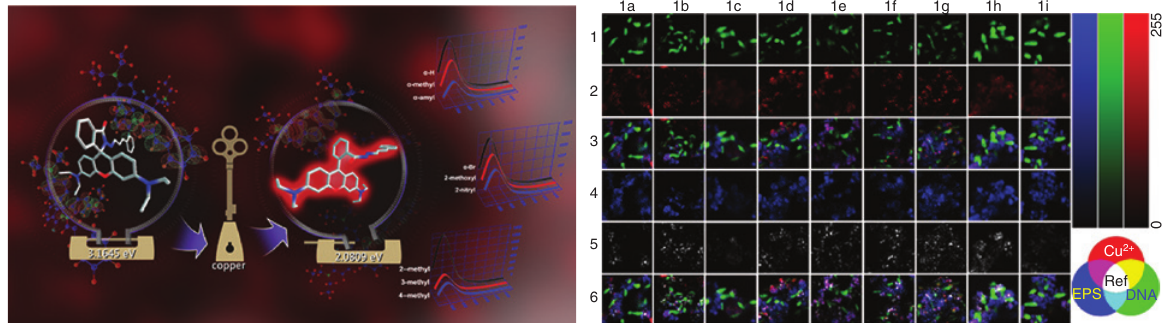
Figure 16: Schematic of the strategy for studying the structure-property relationships of nine modular Cu 2 + fluorescent probes and single- cell scale maps showing the sorption of Cu 2 + to cell-EPS-mineral aggregates. Reprinted from She et al. (2016).